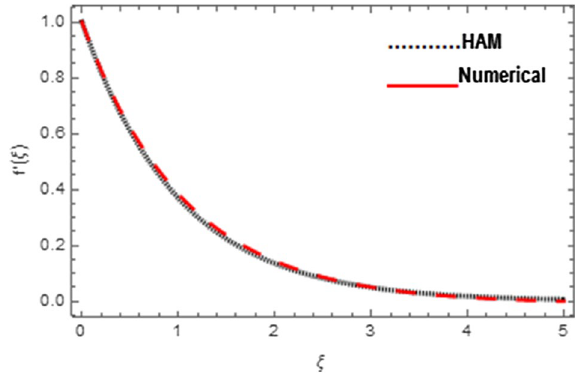
Figure 4. Association between HAM and Shooting techniques for velocity field.